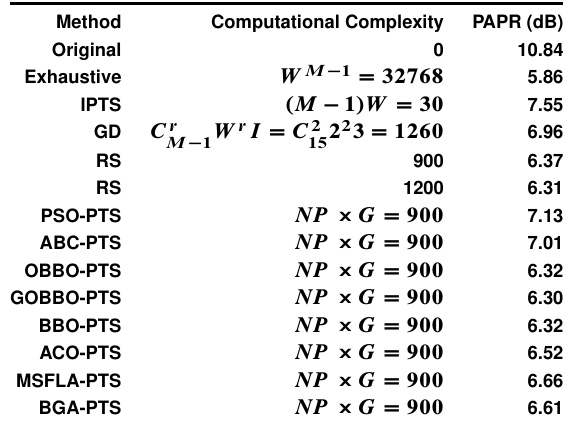
Table 4. Comparison of computational complexity for CCDF D 10 (cid:0) 3 among different PTS schemes.